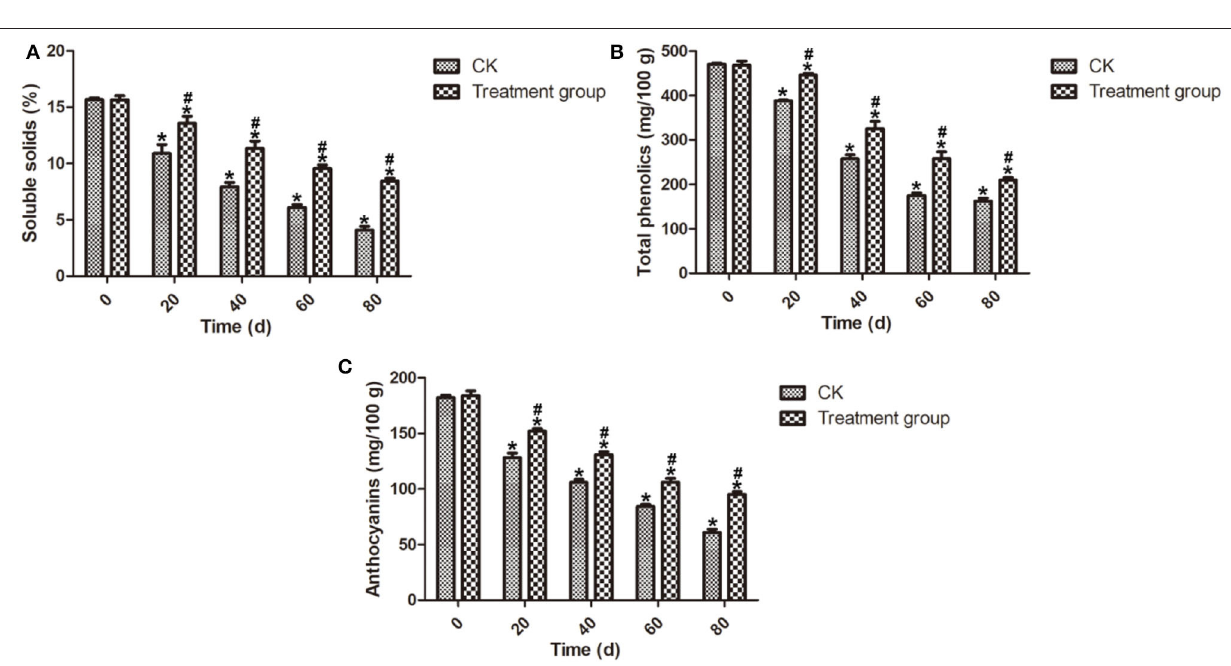
FIGURE 4 | Effects on the soluble solids, total phenolics, and anthocyanins contents of the postharvest blueberries after ozone fumigation treatment. (A) Effect on the soluble solids content, (B) effect on the total phenolics content, and (C) effect on the anthocyanins content. “*” indicated the decay rates and fruits firmness of ozone fumigation treatment with a significant difference at p < 0.05 compared with the decay rates and fruits’ firmness at 0 d. “#” indicated the inhibition rates of ozone fumigation treatment with a significant difference at p < 0.05 compared with the CK